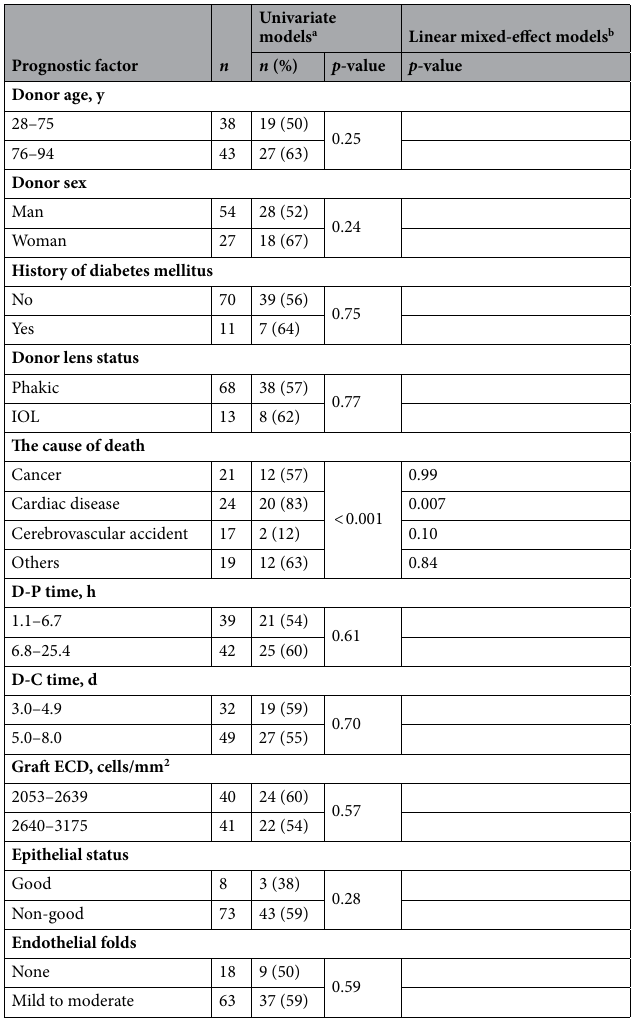
Table 3. Factors associated with deeper cutting (N = 81). D–C, death to cutting; D–P, death to preservation; ECD, endothelial cell density; IOL, intraocular lens. a The percentage of donor corneas that were cut deeper than the mean value in each microkeratome head size by the chi-square test/Fisher’s exact test. b Analyzed with a linear mixed-effect model adjusted for the corneal thickness and microkeratome head size (fixed effect), and the cause of death (random